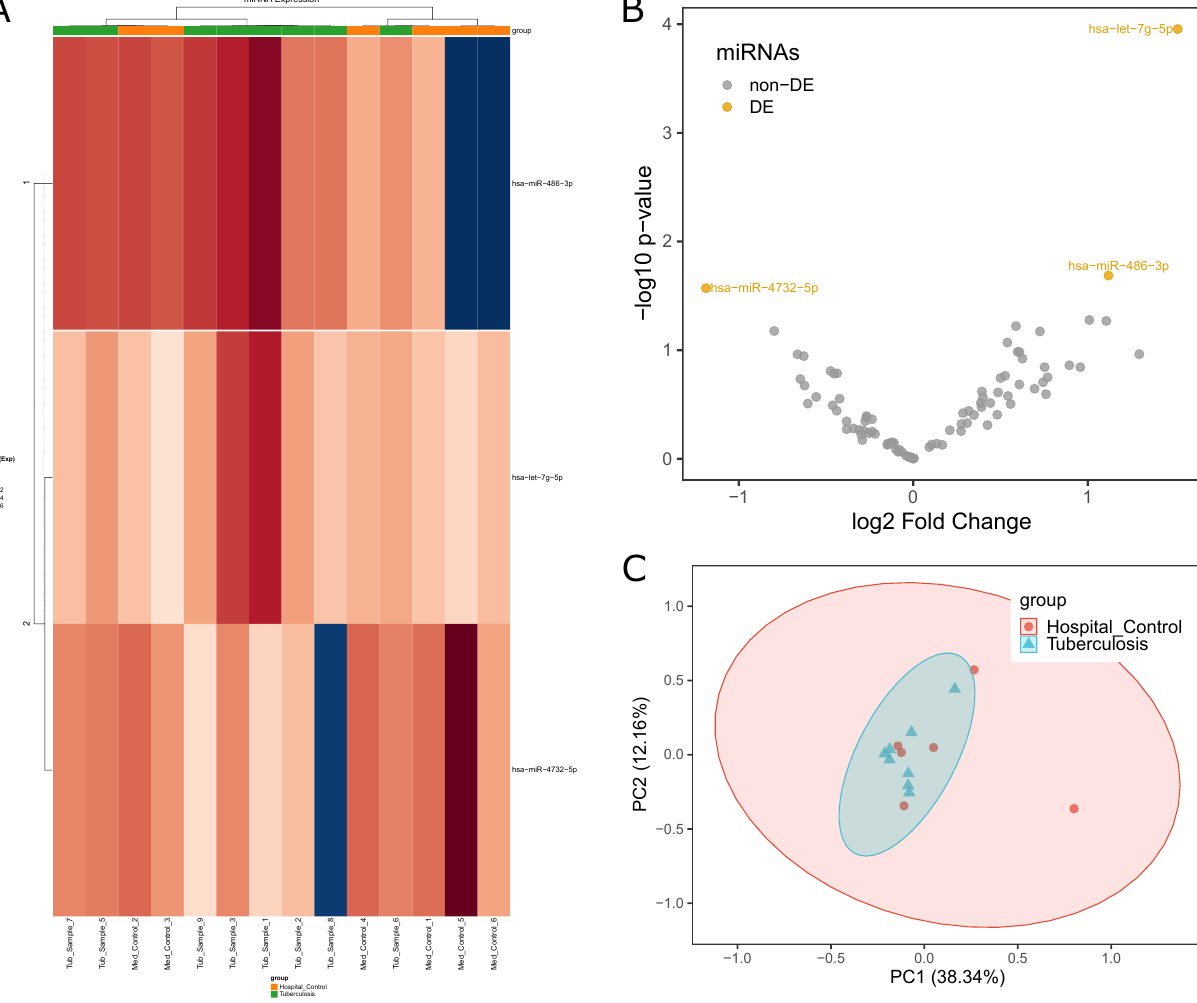
Figure 3. Differential miRNA expression profiles between Tuberculosis patients and Hospital Control samples: ( A ) difference in expression levels of miRNAs between the two groups (HC, orange; TP, green) indicated by a heatmap; ( B ) volcano plot highlighting three miRNAs with differential expression; and ( C ) PCA plot highlighting the homogeneity and separation of the groups based on miRNA